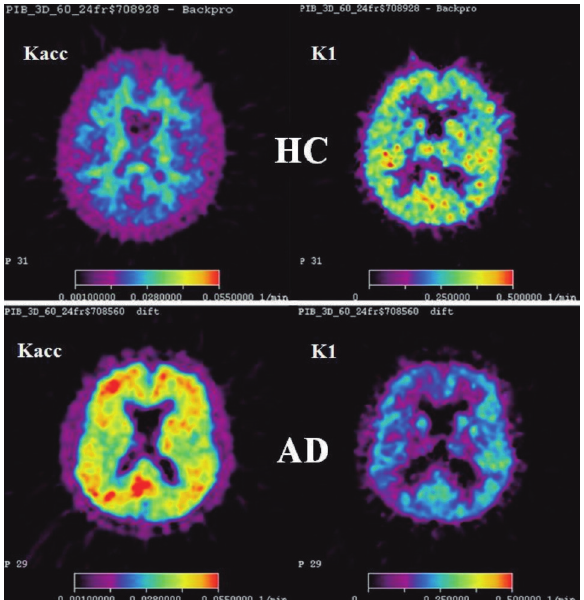
Figure 3. Parametric maps of the net accumulation rate constant Kacc (left) and the unidirectional influx rate constant K1 (right). Upper row: HC subject, lower row: